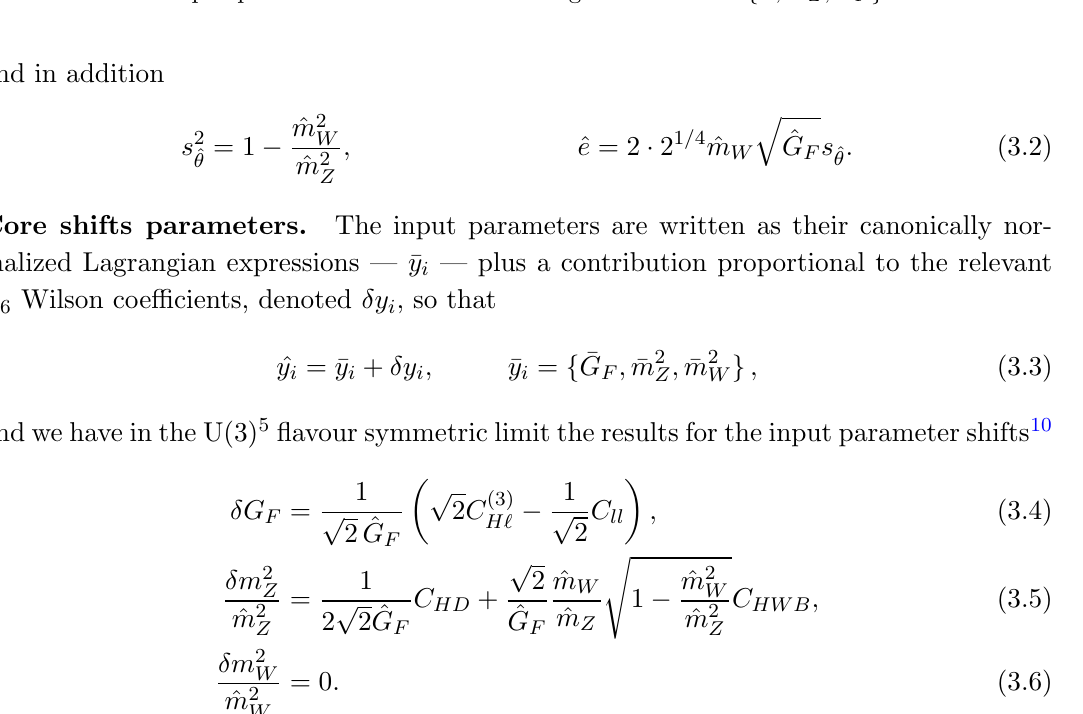
^ (cid:11); ^ m Z ; ^ G F scheme. f g